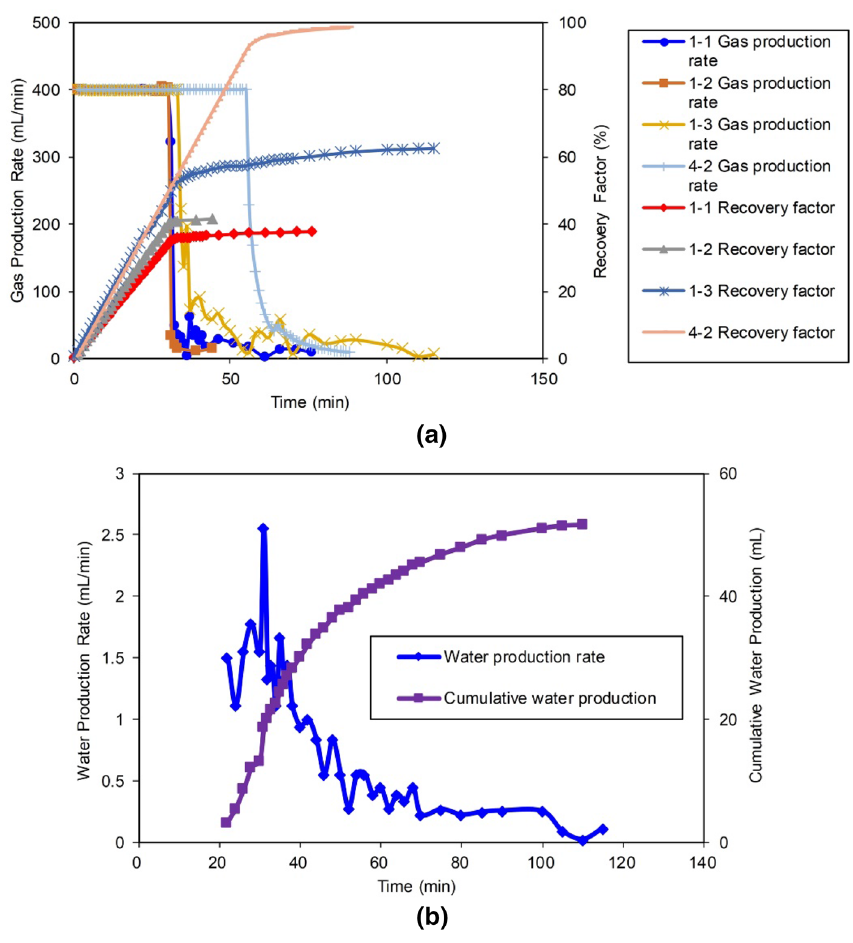
Figure 5. Production performance of the Group I: ( a ) gas production, and ( b ) water production of Experiment 1-3.